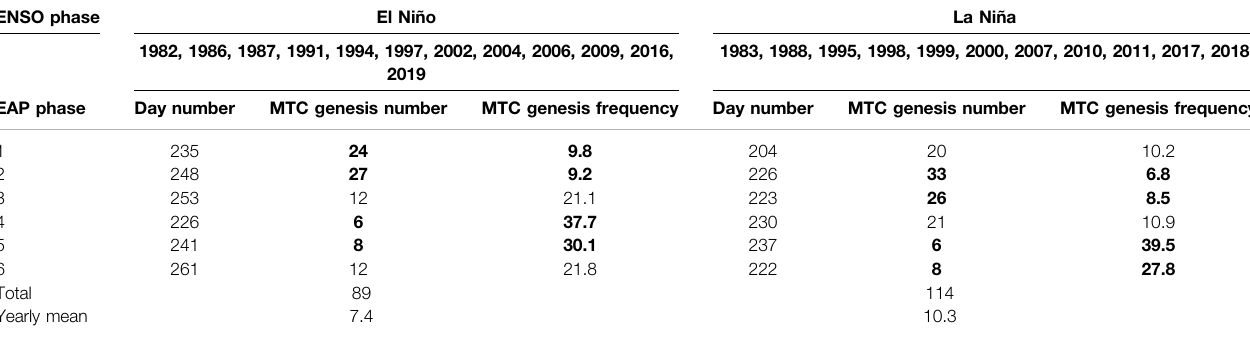
The bold numbers represent the value passing the 95% con fi dence level tested by the Monte Carlo way ( n (cid:1) 5,000).